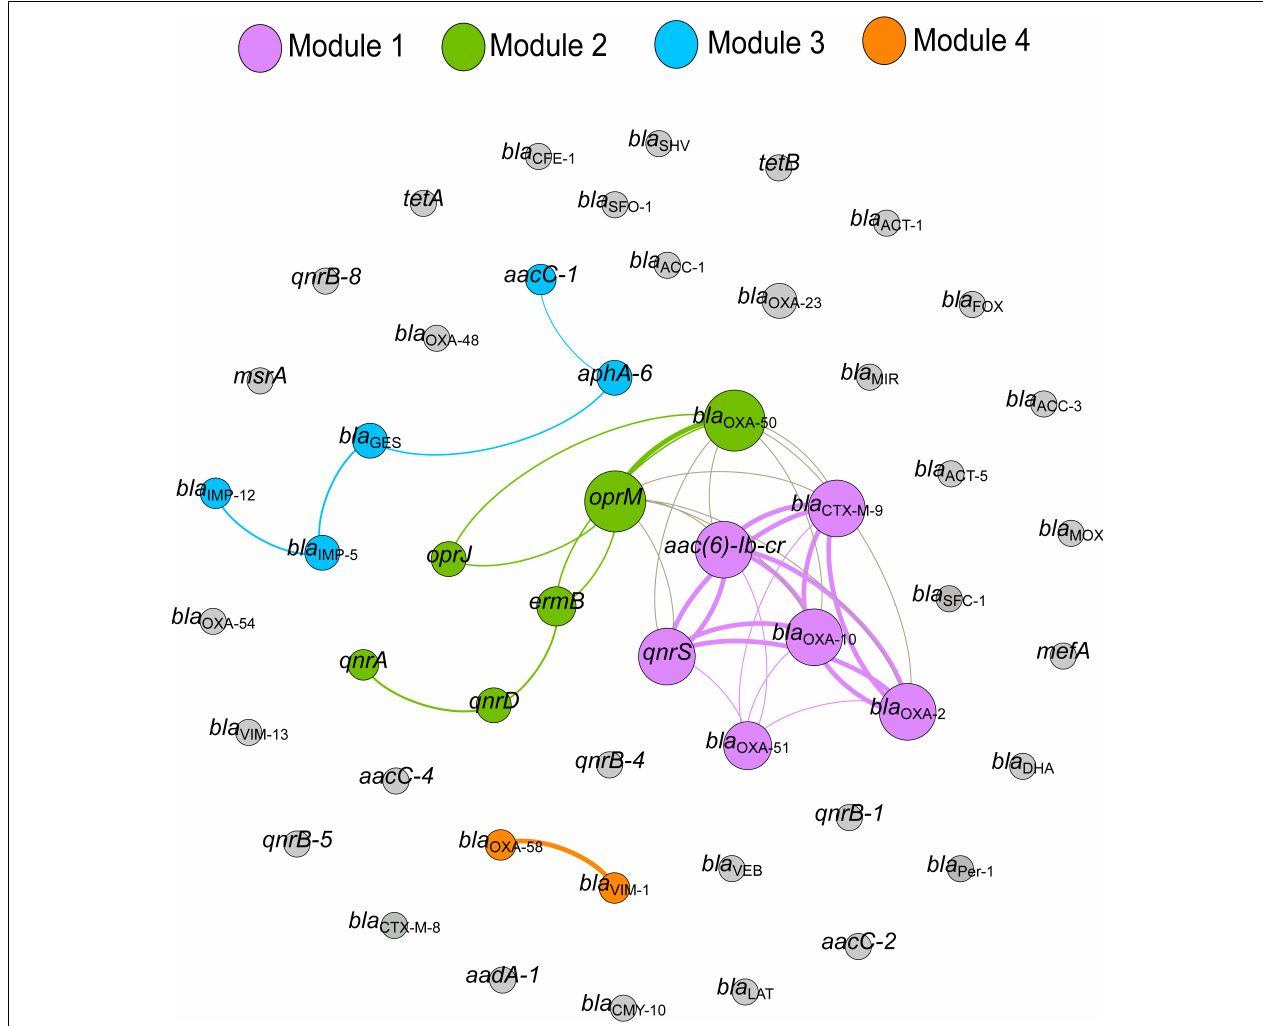
FIGURE 6 | Network plot showing co-occurrence of ARGs detected in wastewater and environmental water samples in Örebro, Sweden. The co-occurrence network is based on a correlation matrix among detected ARGs using Spearman’s rank correlation. Only correlations with a high correlation coefficient ( p ≥ 0.8) and low P -value ( P- value 0.01) are shown. The node size represents the number of connections with other ARGs. The thickness of the edge is proportional to the Spearman’s correlation coefficient ( p ) of the connection. The co-occurrence network is further divided into sub-networks (modules) based on modularity class (modularity index = 0.477). Genes in gray color do not show a significant